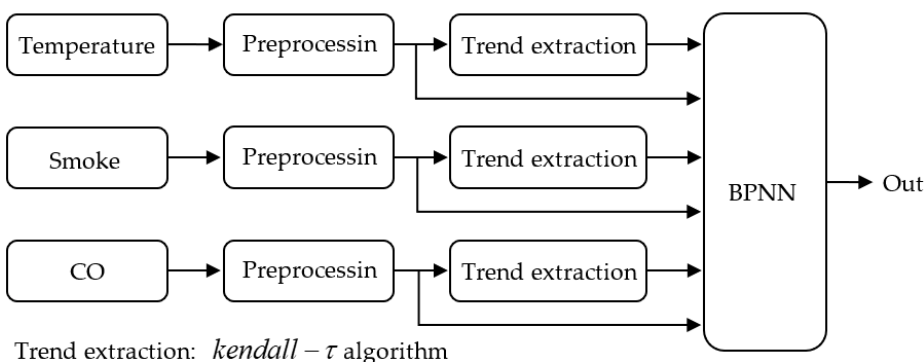
Figure 2. The frame of the indoor fire early warning model.